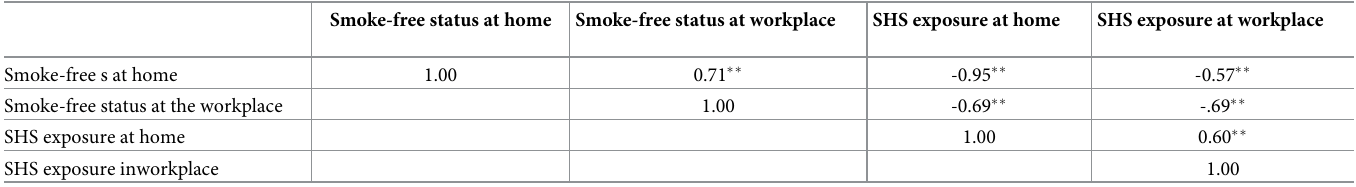
Table 4. Correlations between smoke-free status of the home and workplace and SHS exposure (N = 30 State + 2 Unions = 32). Smoke-free status at home Smoke-free status at